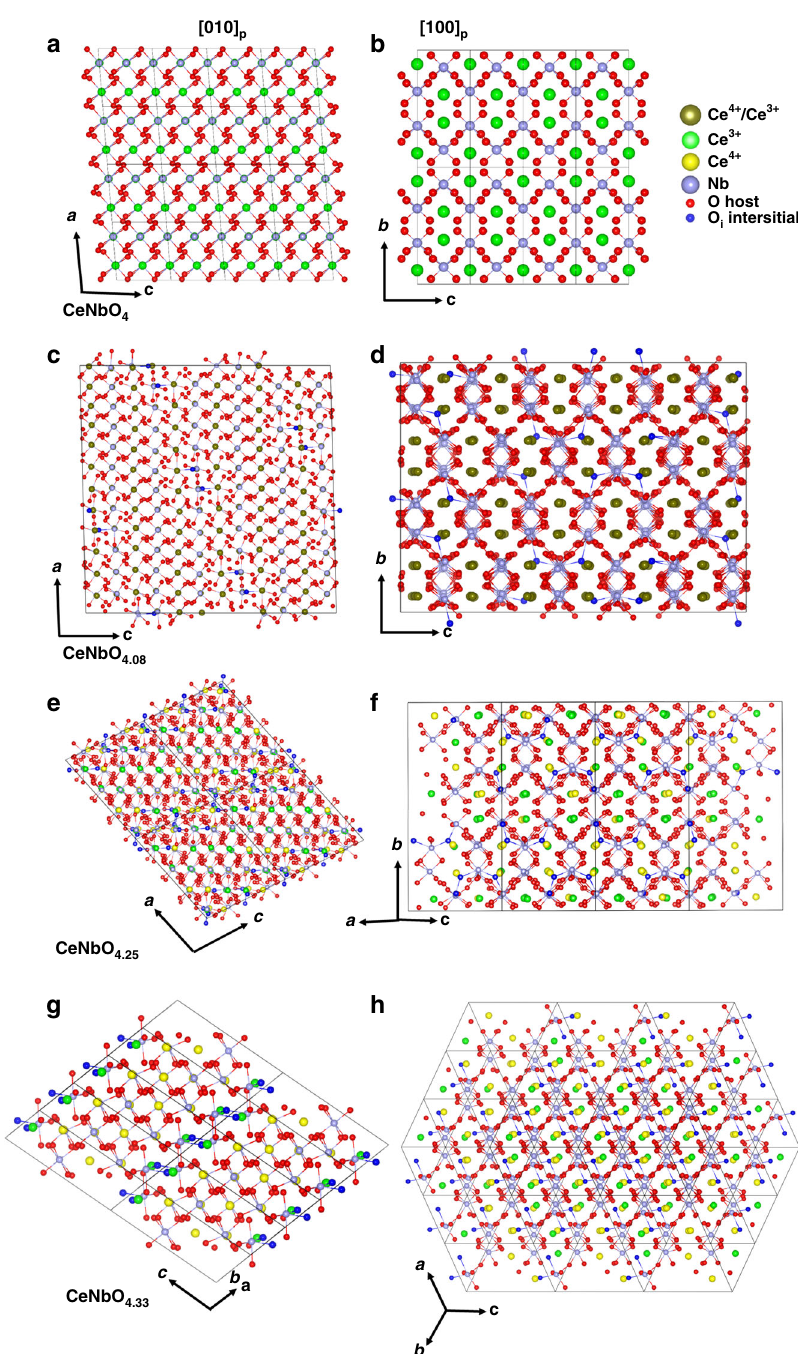
Fig. 4 Structure model of CeNbO 4 + δ . CeNbO 4 ( a , b ), oxidized CeNbO 4.08 ( c , d ), CeNbO 4.25 ( e , f ), and CeNbO 4.33 ( g , h ) projected along the principal axes of [010] p and [100] p . Displacement of oxygen from the original position in the parent structure is observed. Note that c and d were 6 a × 2 b × 6 c approximant superstructure in (3 + 1)D incommensurately modulated model along [010]p and